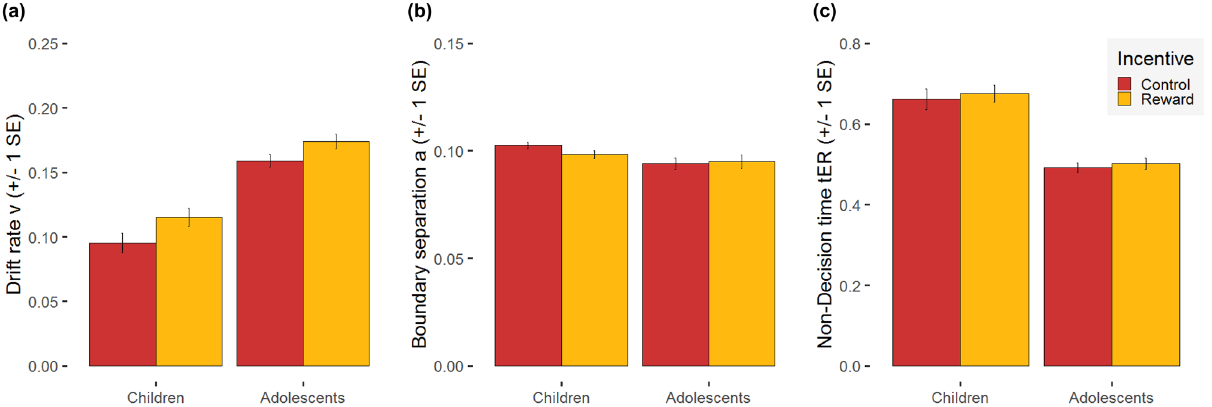
Figure 3. Model parameters of the decision-making process: Mean and standard error (SE) for ( a ) drift rate (v), ( b ) boundary separation ( a ), and ( c ) non-decision time (t ER ), separated for the two incentive conditions (reward vs. control) and the two age groups (children vs.